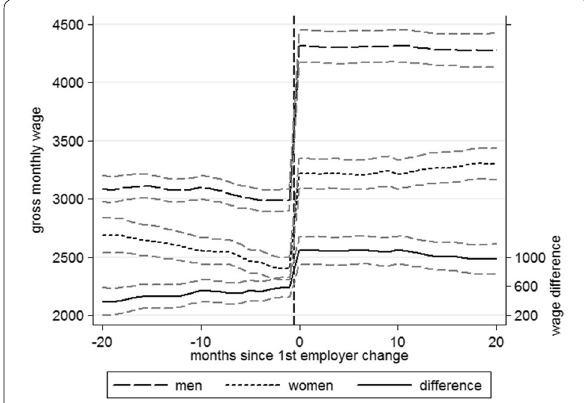
Fig. 5 Gender-specific changes in income: monthly income of employer changers and 95% CIs ( Source BAP 2005/06, author’s calcu- lations; created with Stata13)